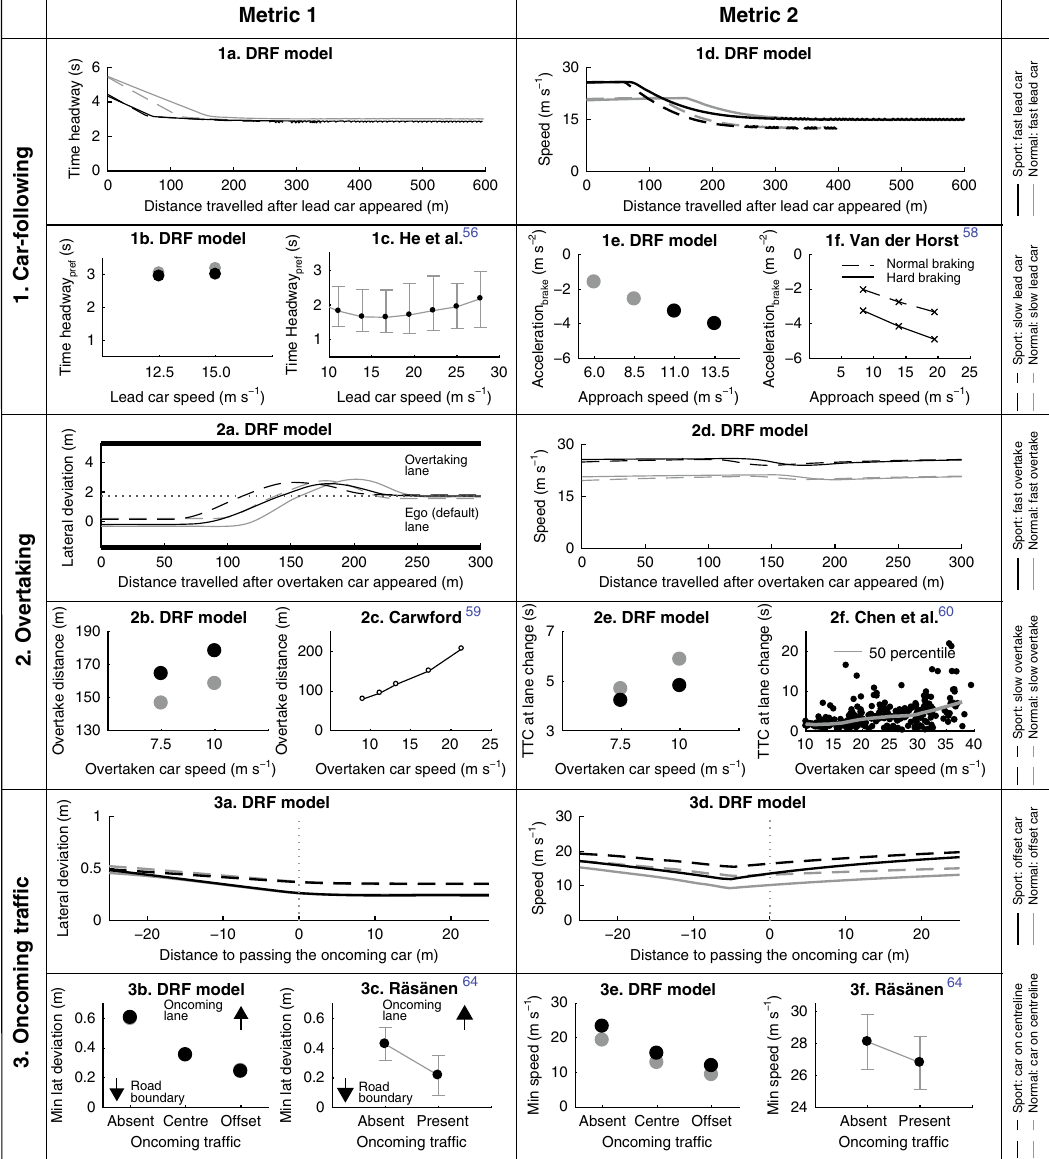
Fig. 5 Validating the model in traf fi c scenarios using literature. Similar to Fig. 4, each row represents one scenario and the two metrics in the two columns compare the DRF model results to trends shown in the literature (Supplementary Notes 9 – 14). For the DRF model fi gures, the black and the grey markers represent the sport and normal parameter settings, respectively (Supplementary Figs. 7 – 9). 1 Car following: 1b and 1c indicate that the preferred time headway is independent of the speed. In 1c, the circular markers indicate the median and the whiskers indicate 25th and 75th percentile. 1e and 1f show that the braking intensity (represented by the acceleration at brake initiation) increases as the approach speed to the obstacle increases. 2 Overtaking: 2b and 2c show that the DRF model could correctly predict that the overtake-distance increases as the speed of the overtaken car increases. In the sport setting, the model covers larger distance than in normal setting, indicating ‘ smoother ’ trajectories in the sport setting. However, the DRF model does not come back to its own lane suf fi ciently (2a). Sub fi gures 2e and 2f show that the predictions of the DRF model agree with the results in literature that show the time to collision (TTC) at the start of the overtake manoeuvre increases, as the speed of the overtaken car increases. 3 Oncoming traf fi c: In 3b and 3c, the minimum lateral deviation is shown on the y - axis. The condition where no oncoming cars were present is indicated by ‘ absent ’ . The DRF model simulated one car that drove on the oncoming lane ’ s centre ( ‘ centre ’ in 3b) and another car that was offset towards the ego lane ( ‘ offset ’ in 3b). In normal and sport setting the DRF model moved away from the oncoming traf fi c, which is in agreement with the driver ’ s behaviour. 3e and 3f show that the DRF model slowed down, like humans (3f), when it encountered oncoming traf fi c. In 3c and 3f, the black markers indicate mean, and whiskers indicate the